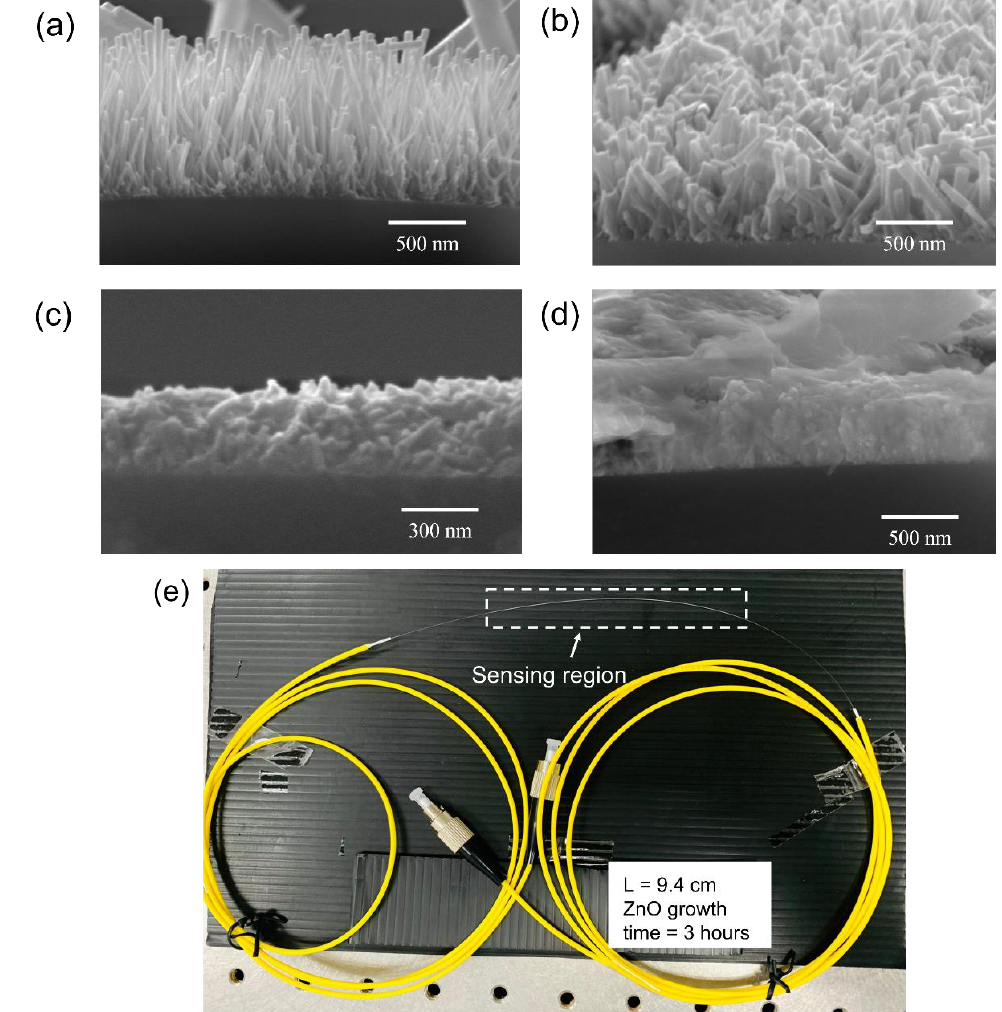
Figure 4. SEM micrographs of ZnO nanorods on CSF with growth times of ( a ) 3 h; ( b ) 4 h; ( c ) 5 h; and ( d ) 7 h, and ( e ) fabricated sensor with the sensing length of 9.4 cm.